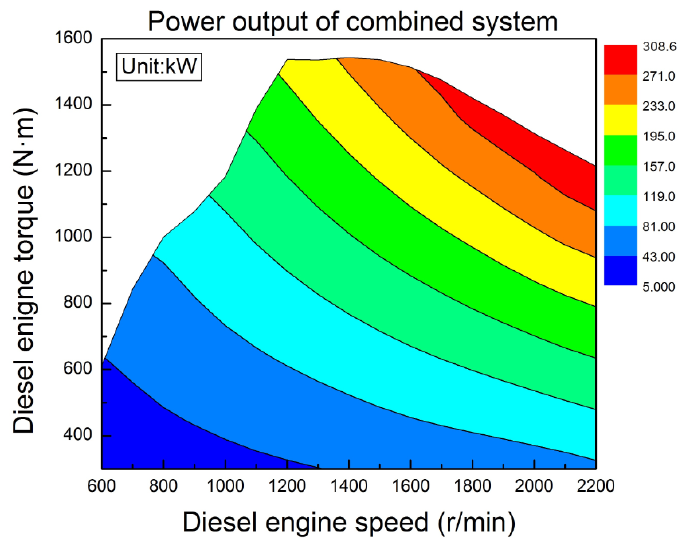
Figure 10. Power output of the combined